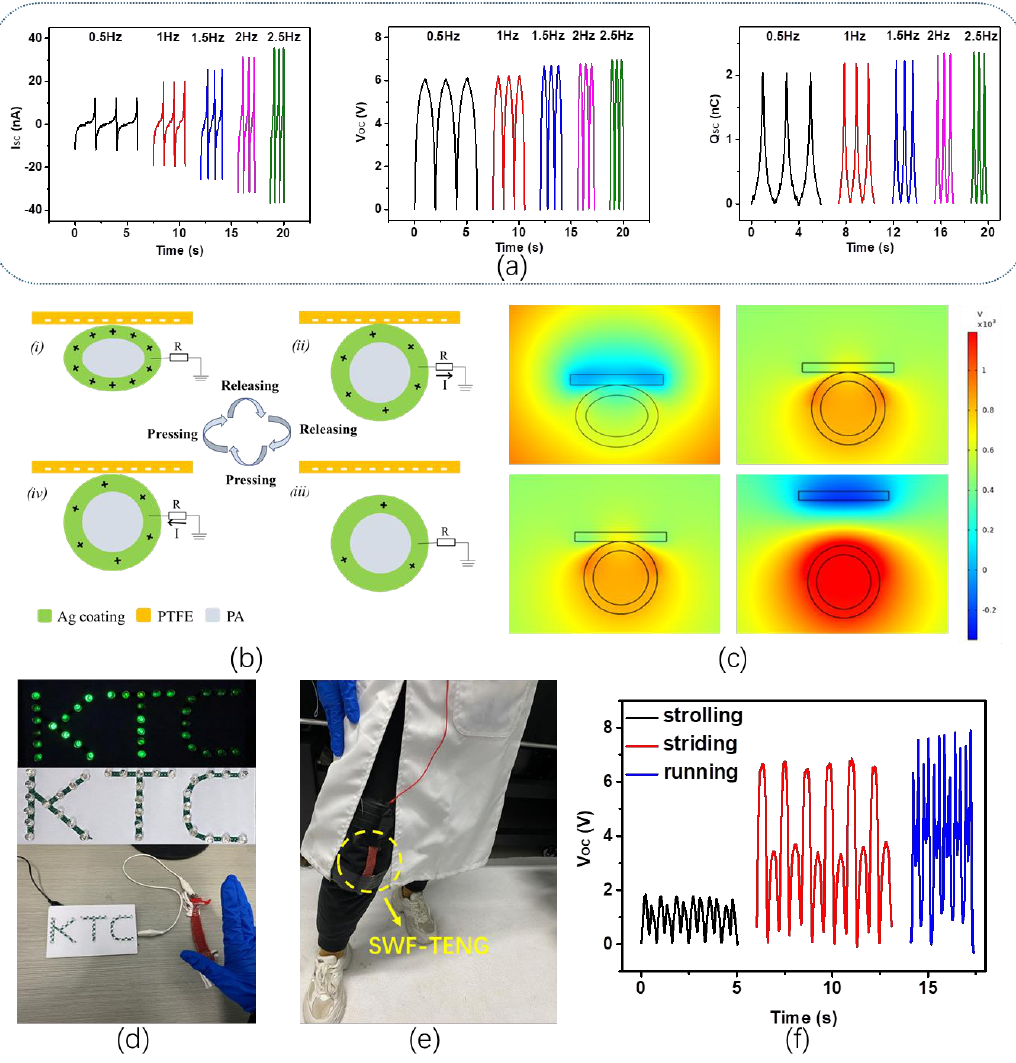
Figure 8. ( a ) The electrical output performances of SWF-TENG under press mode with different frequencies; ( b ) The working mechanism of SWF-TENG under press mode, ( i ) In the original state with pressure between the PTFE film and the fabric; ( ii ) The SWF−TENG and the PTFE film are gradually separating; ( iii ) The PTFE film is moving quite far away from the SWF−TENG ; ( iv ) The PTFE film is contacting the SWF−TENG gradually; ( c ) Simulated electric field distribution of SWF − TENG under press mode; ( d ) Demonstration of lighting up 34 LEDs marked as alphabets “KTC” by only hand tapping the fabric TENG; ( e ) The testing interface of the SWY − TENG as a real-time bend – stretch sensor; ( f ) V OC of the SWY − TENG as a real-time bend – stretch sensor.